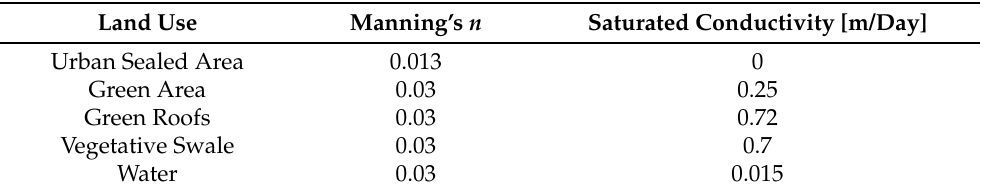
Table 3. The roughness coefficient Manning’s n and the saturated conductivity ( K sat ) defined for each land use